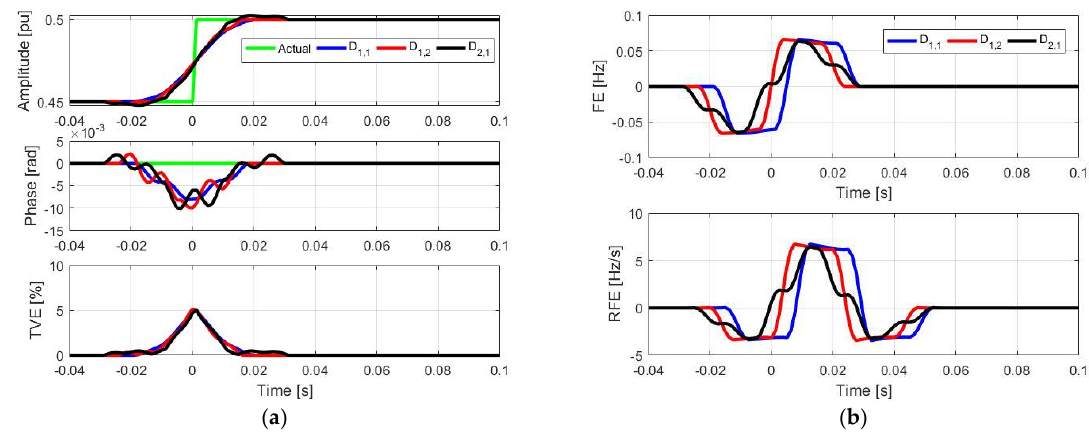
Figure 8. Simulation results obtained for the amplitude step signal, for K = 1 for D 1,1 = 16 and D 1,2 = 20, and K = 2 for D 2,1 = 24, with f 1 = 50 Hz and f S = 800 Hz ( N = 16): ( a ) amplitude, phase and TVE, and ( b ) FE and